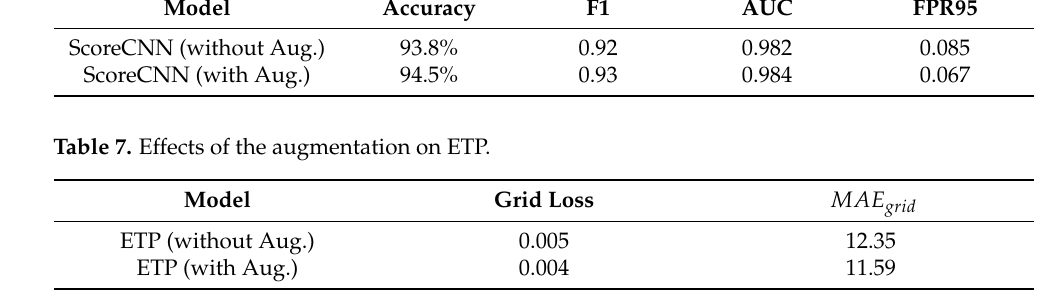
Table 5. Comparative results of different architectures and inference procedures on validation set. “S → T” and “T → S” indicate the predicted transformations in two inference directions of the same trained model. “Bidirection” refers to the two-stream model trained bidirectionally and as an en- semble.